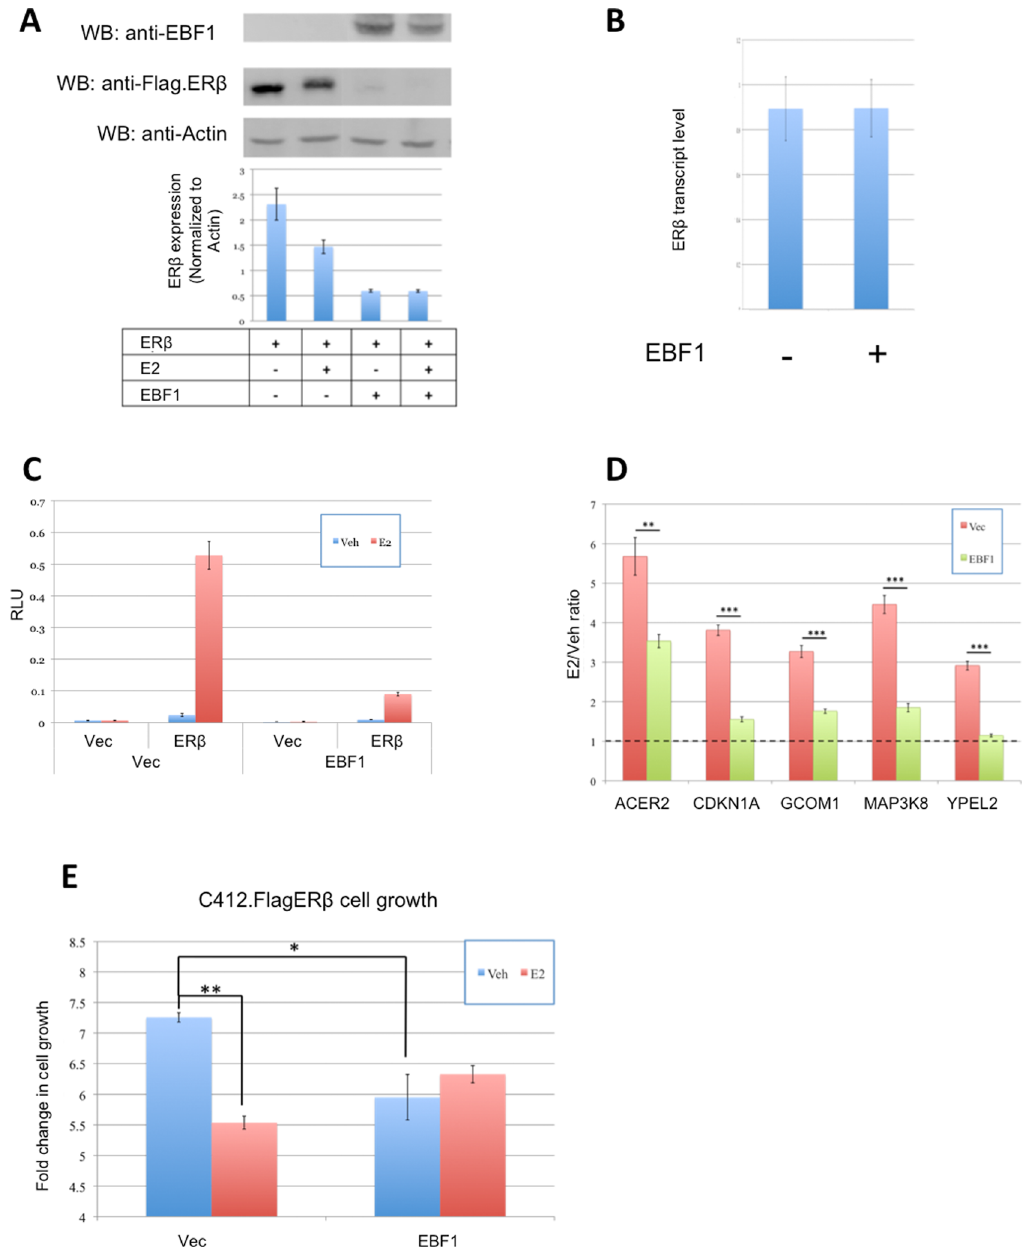
Figure 7. EBF1 negatively regulates ER b protein levels and downstream activity. MCF-7/C4–12 cells were transfected with Flag.ER b in the presence or absence of EBF1 and then treated with E2 or Vehicle control. (A) Flag.ER b protein and (B) mRNA levels were measured on Western blots and by RT-qPCR, respectively. ER b transcriptional response was measured in an (C) ERE-Luciferase reporter assay as well as (D) by endogenous target gene regulation. (E) C4–12/Flag.ER b cells were transfected with EBF1 (or pcDNA3.1(-) as Vector control) and treated with E2 for 3 days. Cell confluency, detected by the Incucyte FLR, was used to measure cell proliferation. The bar graph represents the fold change relative to day 0. Error bars represent standard